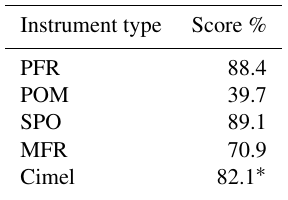
Table 3. Percentage of available cloud-screened AOD data values out of all possible measurements